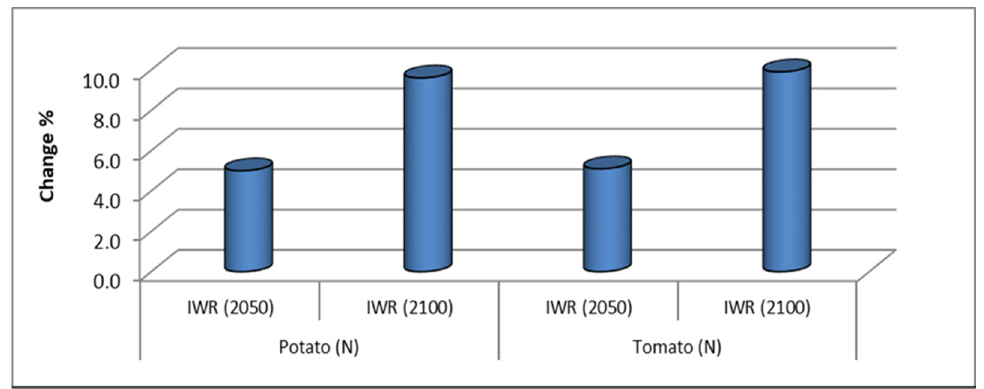
Figure 10. Change percentage in irrigation water requirements (IWR) for some Nili crops in Middle Egypt under climate change conditions compared to current conditions.